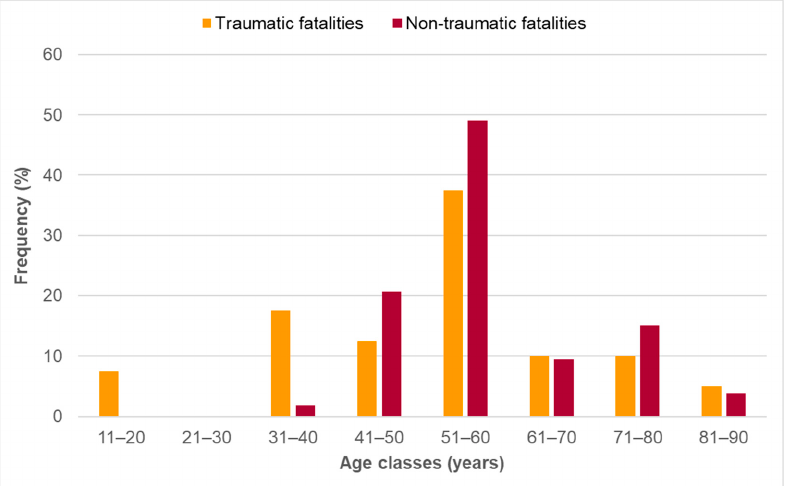
Figure 1. Overall cause of mortality during recreational MTB in the Austrian Alps in the period 2006–2021 divided by age class (n = 93). Orange columns = traumatic fatalities (n = 40), red columns = non-traumatic fatalities (n = 53). Values are relative frequencies. Significance level: p = 0.0503.